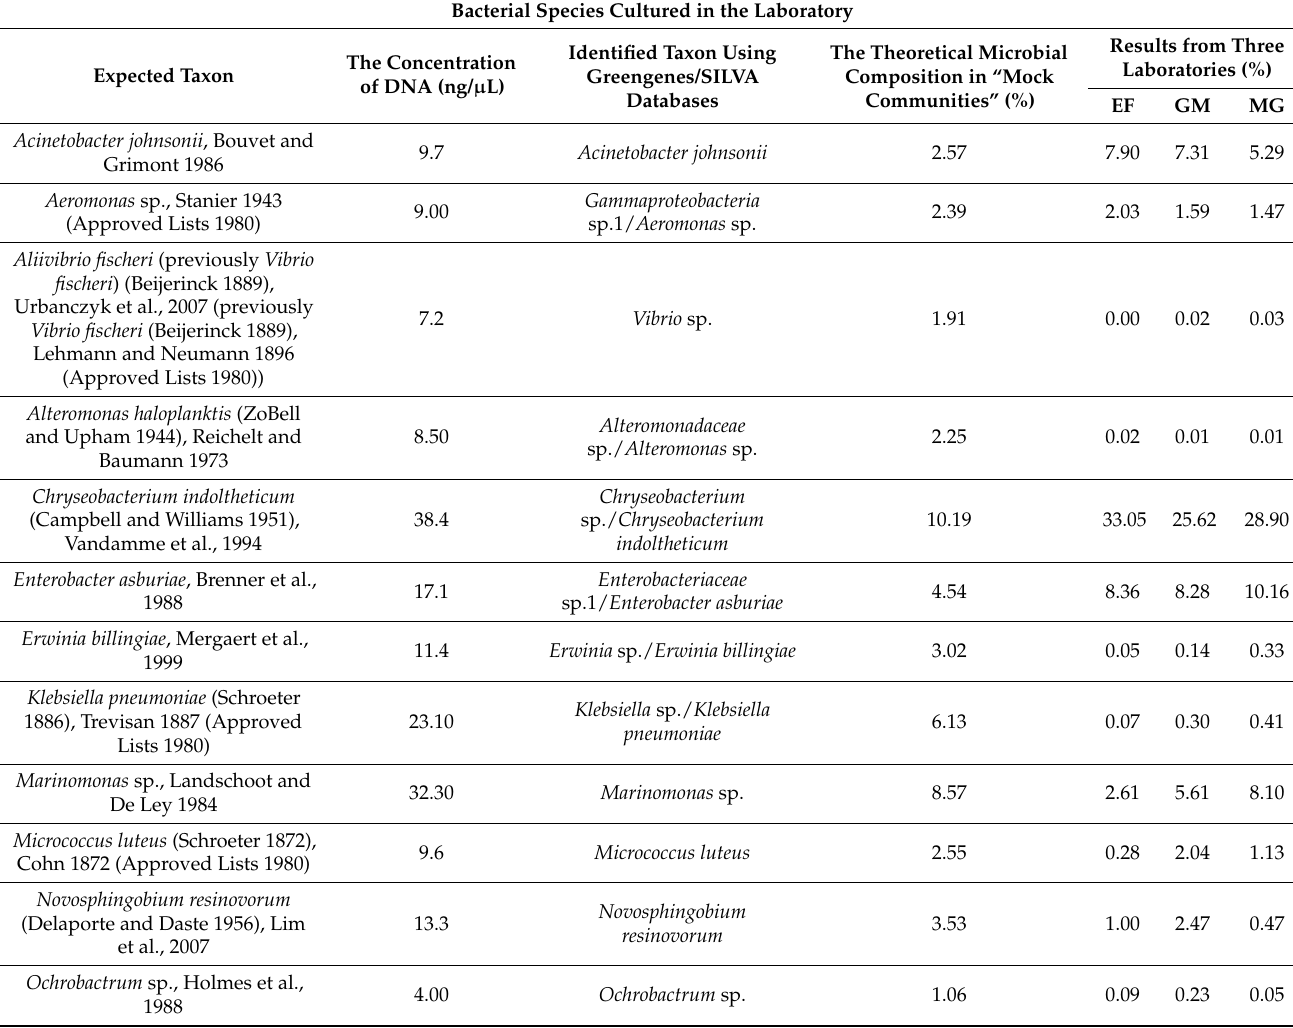
Table 7. Comparison of HTS results for the “mock communities” obtained from three different commercial